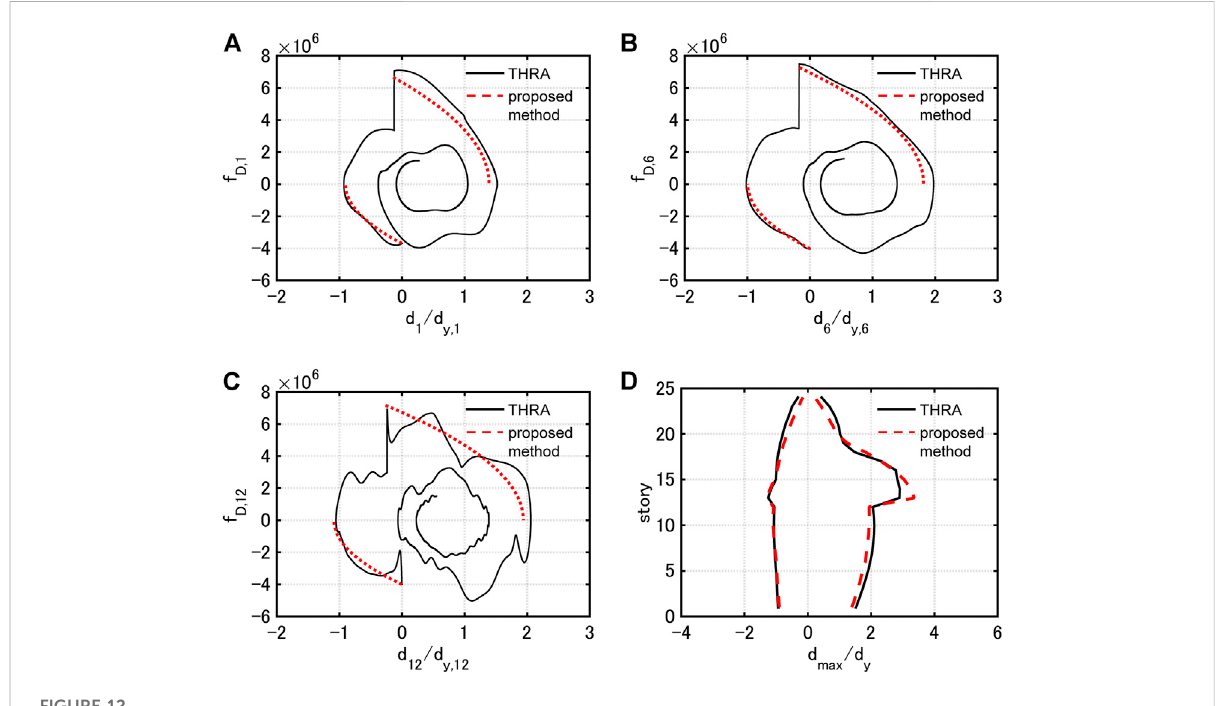
FIGURE 12 Damping force-interstory drift relation under PDI with V (cid:1) 1 . 2m / s (Model 2) by time-history response analysis and proposed method, (A) 1st story, (B) 6th story, (C) 12th story, (D) maximum interstory